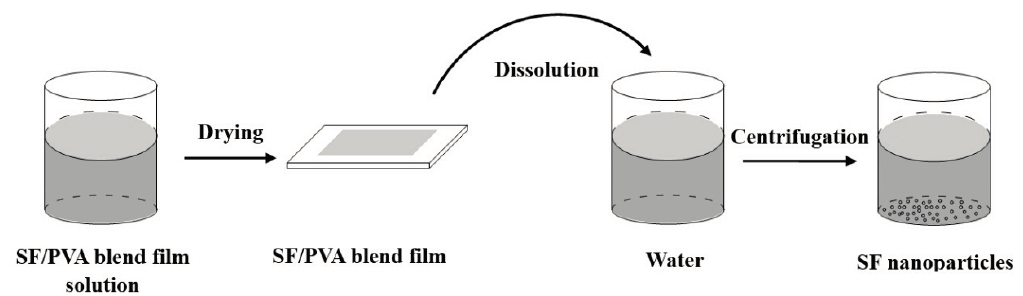
Figure 9. Schematic diagram of the PVA blend film method for preparing SF